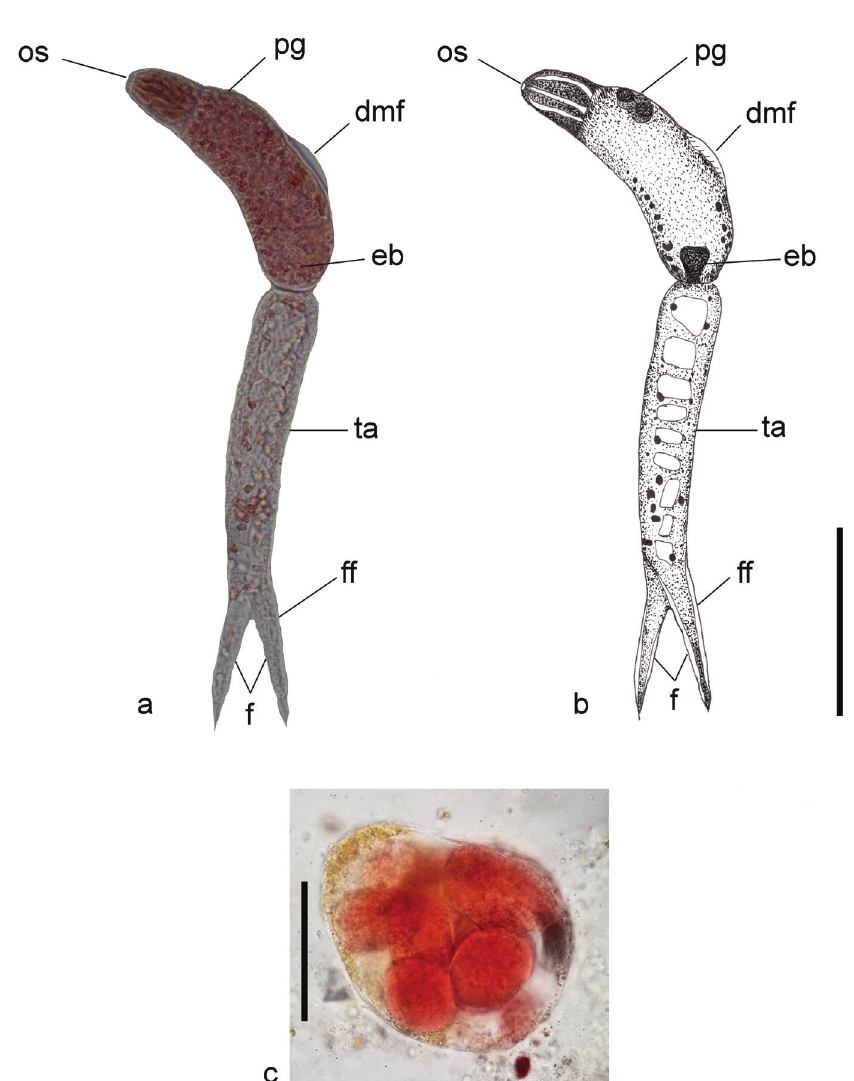
Figure 13. Cardicola alseae Meade & Pratt, 1965. a . specimen stained with 0.5% neutral red. b . drawing of cercaria. c . sporocyst stained with 0.5% neutral red. Abbreviations – dmf: dorso-median finfold; eb: excretory bladder; f: furca; ff: furcal finfold; os: oral sucker; pg: penetration gland; ta: tail. Scale bars: 50